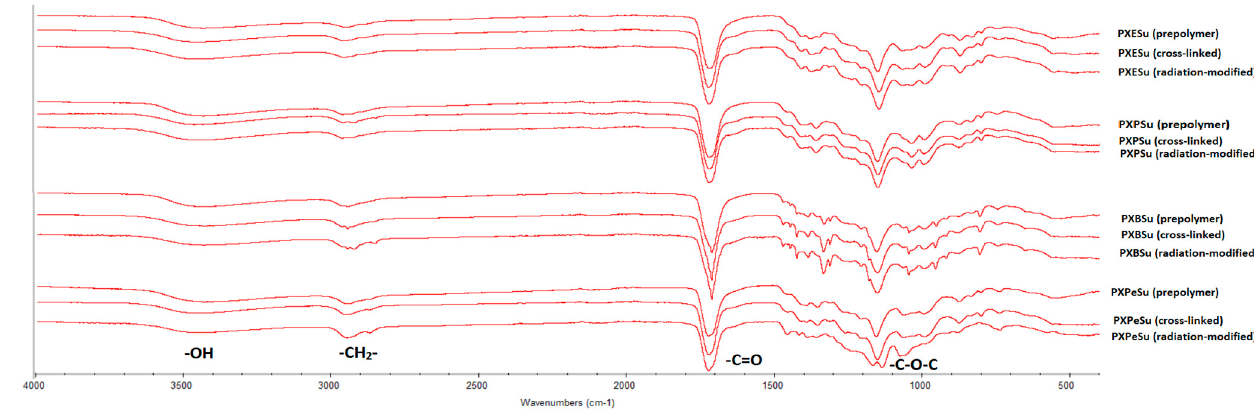
Figure 6. FTIR spectra of PXESu, PXPSu, PXBSu, and PXPeSu prepolymers and polymer crosslinked and polymer after radiation modified.